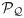
Bygone obstacle rebuttal concept.(a): All the predicted positions of the trajectory lie closer to PQ than the obstacle itself. (b): The straight-line perpendicular to the line that produces the minimum distance between Rf and Ob is represented in black and the hard constraint that replaces the bygone obstacle in the subsequent trajectory is depicted as a red arrow.